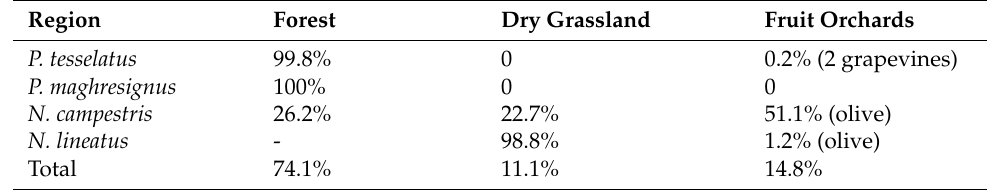
Table 3. Spittlebugs distribution.